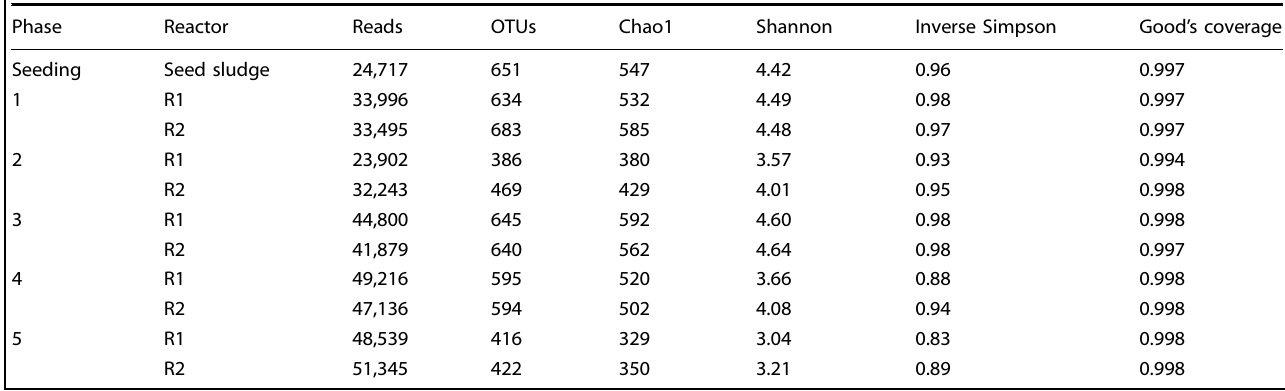
Table 1. Microbial diversity indices for the experimental samples in different